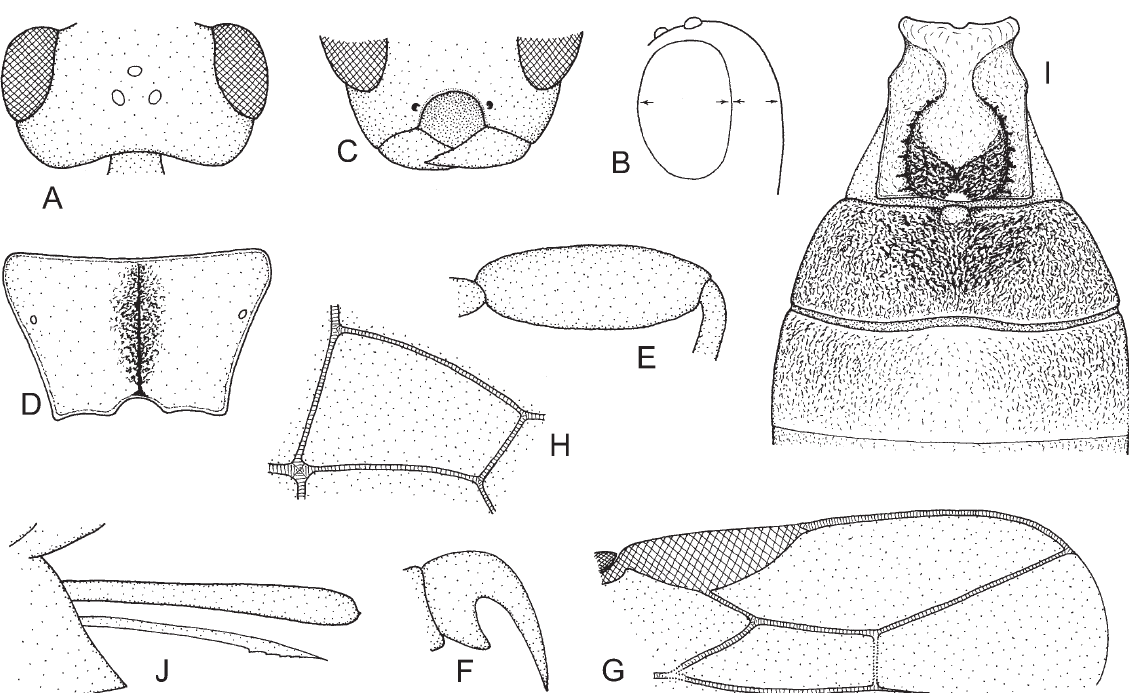
Fig. 18. Bracon ( Bracon ) longicollis Wesmael, 1838, ♀ lectotype. A . Head in dorsal view. B . Head in lateral view. C . Head in frontal view. D . Propodeum. E . Hind femur. F . Claw. G . Distal part of right forewing. H . First discal cell of right forewing. I . Tergites 1-3. J . Hypopygium and ovipositor